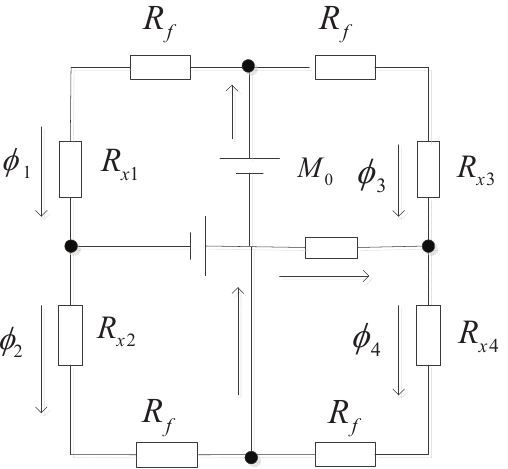
Figure 12. Equivalent magnetic circuit of the torque